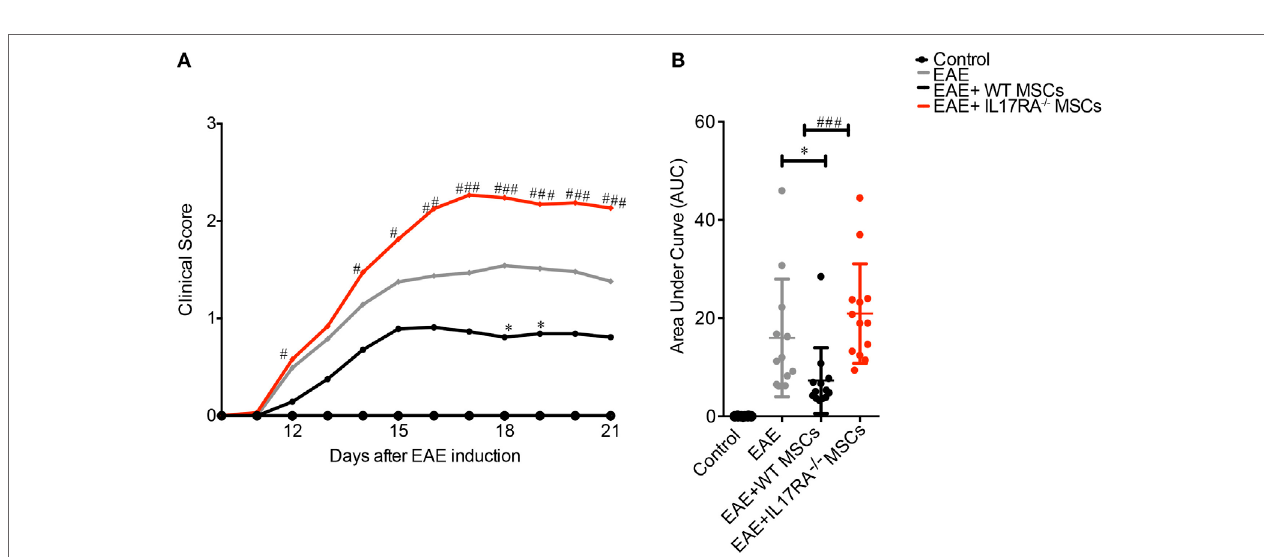
FigUre 4 | Mesenchymal stem cells (MSCs) deficient for IL17RA failed to prevent experimental autoimmune encephalomyelitis (EAE) development and progression. IL17RA silencing diminish the beneficial effect of MSCs on EAE. (a) Daily evaluation of clinical scores were assessed from the day of MSCs injection until the day of euthanasia. (B) The area under the curve (AUC) of the clinical scores represented in (a) for each treatment was calculated. Line curves of the clinical scores analysis represent the mean and the analysis was performed daily. *Symbol represents the comparison between EAE group compared to EAE animals treated with MSCs [Wild-type (WT) MSC or IL17RA − / − ]. # Symbol compares the data between EAE animals treated with WT MSCs and IL17RA MSCs. The AUC of clinical scores were calculated for each experimental group. Statistical differences were calculated using Kruskal–Wallis test. Statistical differences were declared significant at P < 0.05 level (* P < 0.05, ### P < 0.001). The results represent two independent experiments considering 16 mice per group at the beginning of the